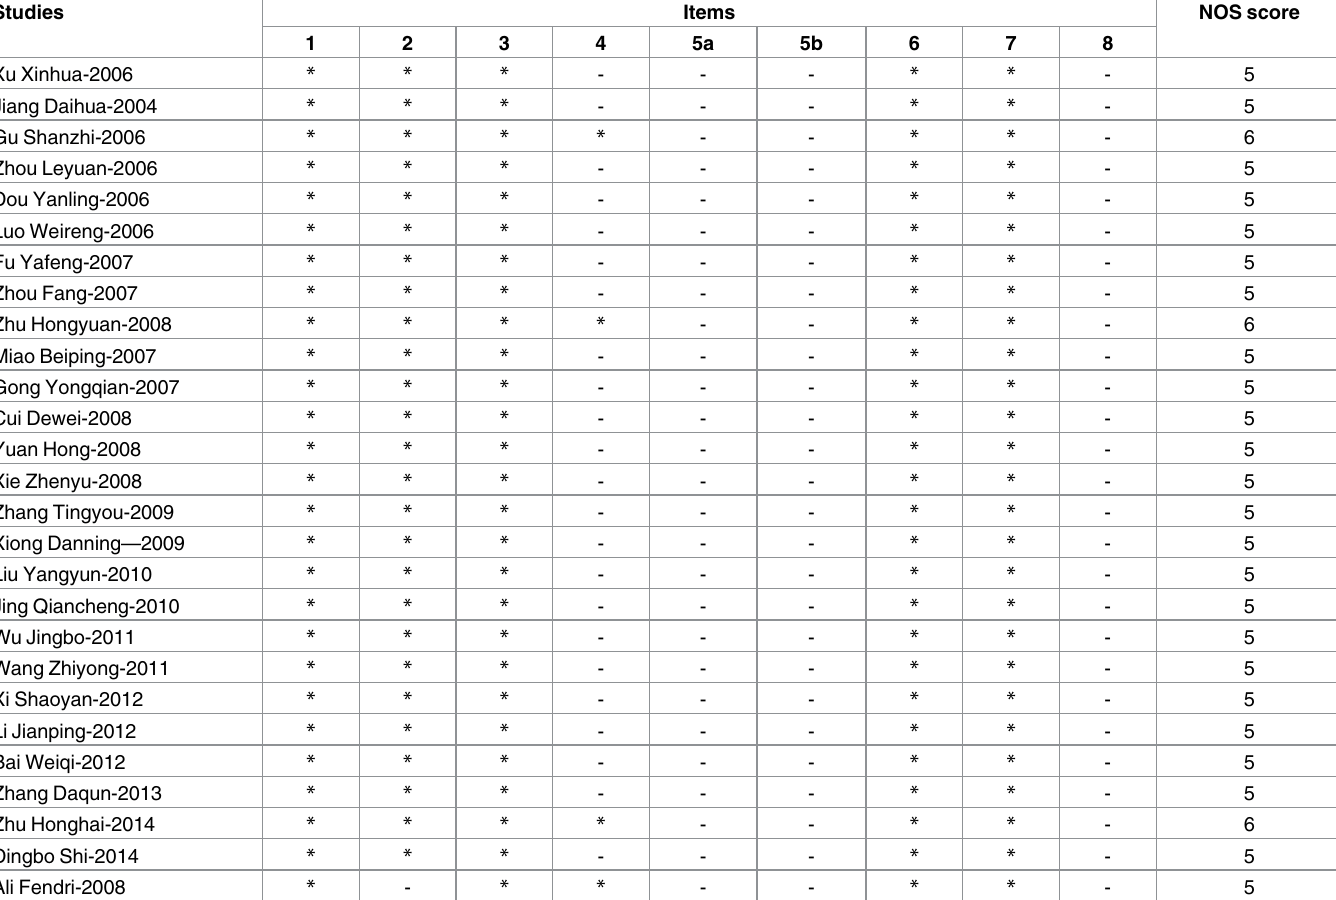
Table 3. Assessment of study quality according to Newcastle-Ottawa Scale